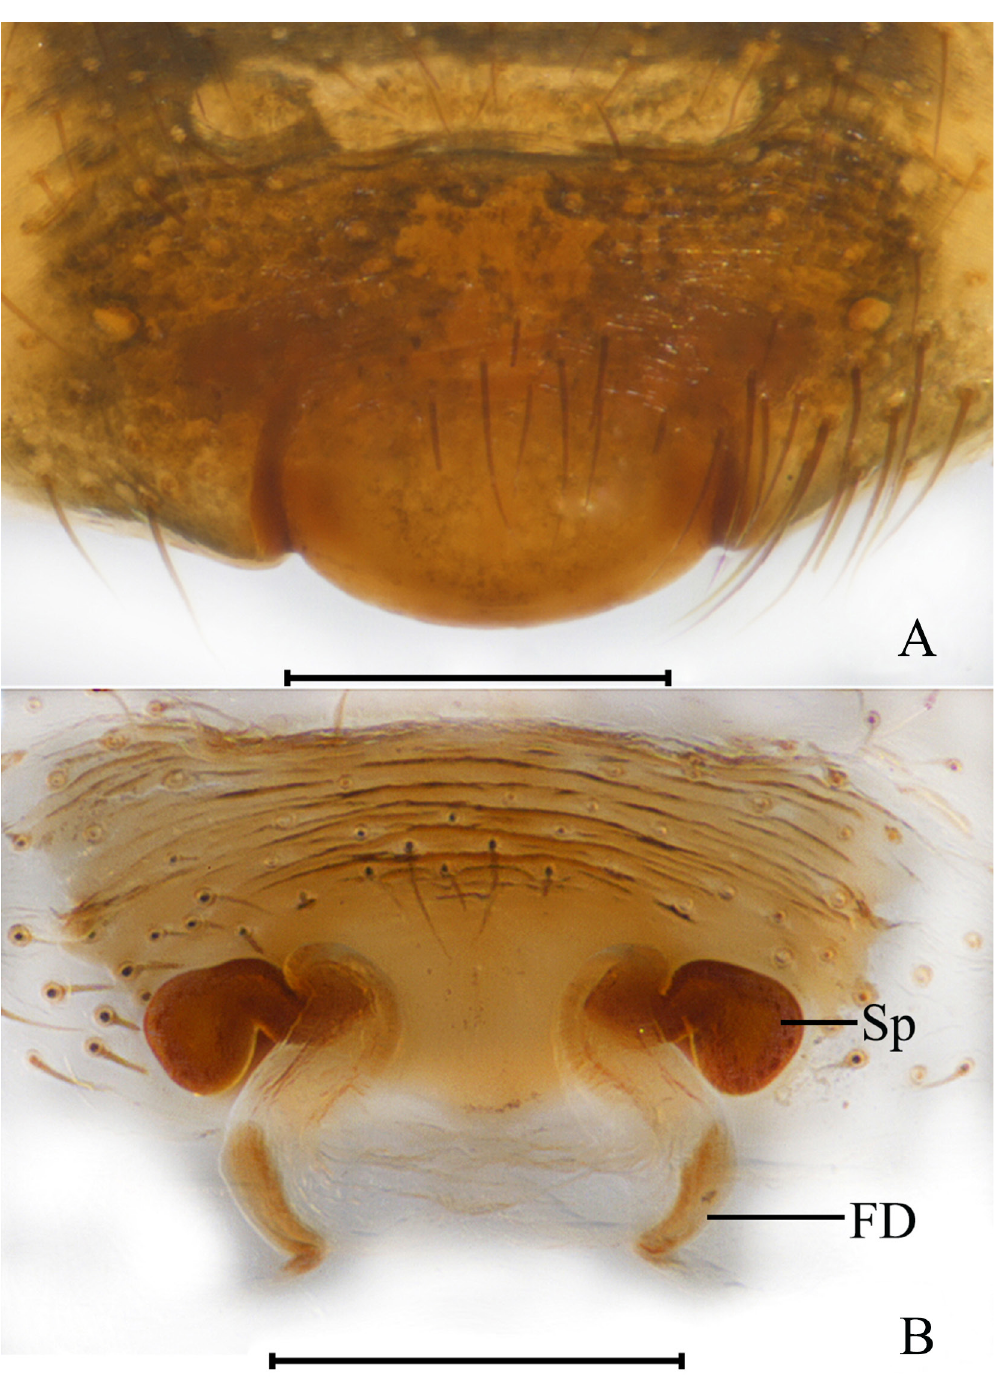
Fig. 3. Meta hamata sp. nov., paratype ♀ (HNU-CGY25). A . Epigyne, ventral view. B . Vulva, front view. Scale bars: 0,2